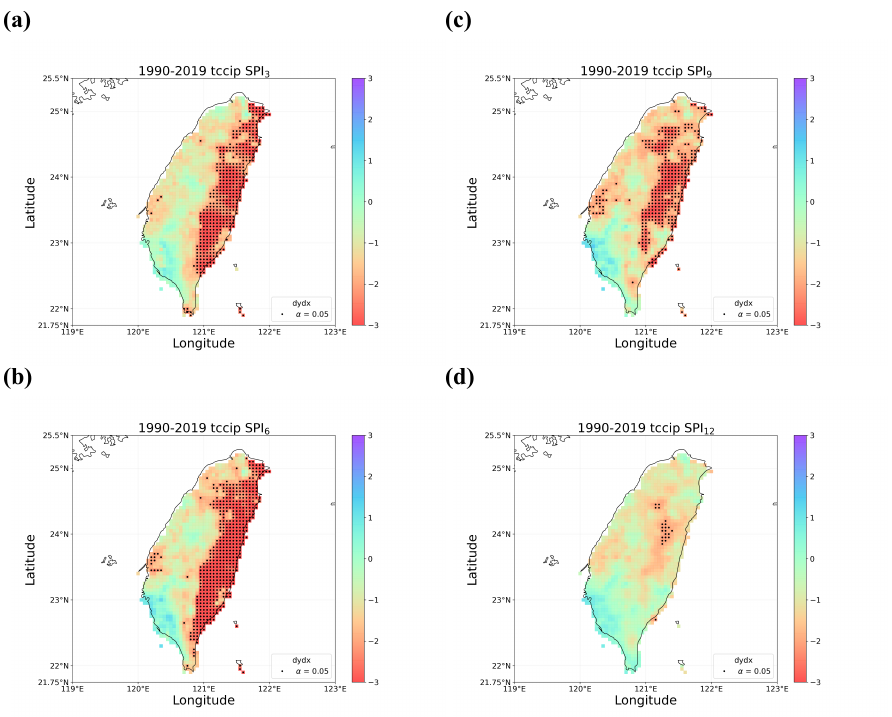
Figure 11. The same as Figure 10, but for detected trends using first derivatives of RMTB.